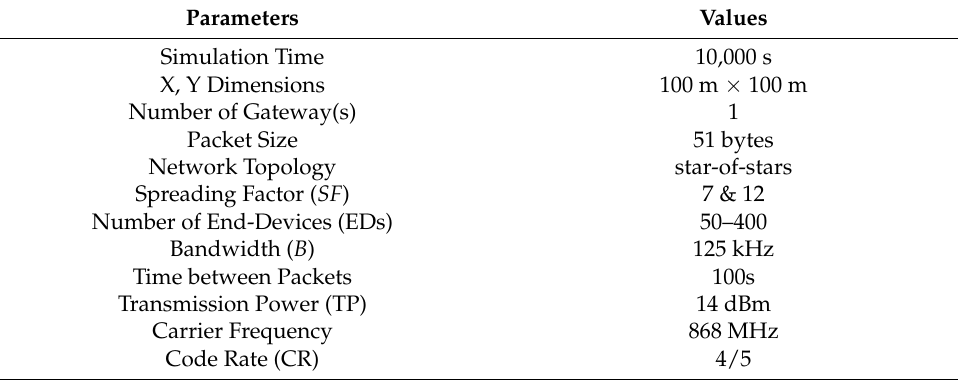
Table 10. Simulation Setup Parameters.